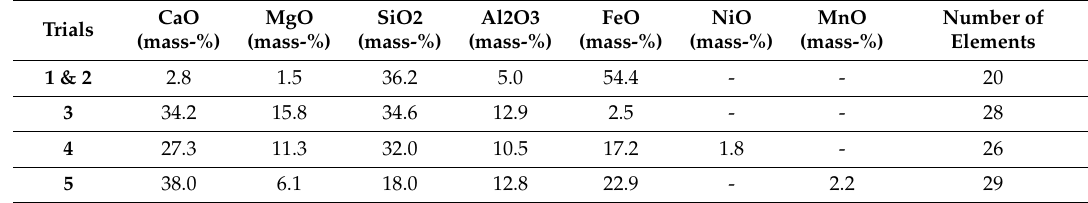
Table 8. Normalized slag composition for the different trials. The number of elements in the slag is also shown, these composition values were not included in the table due to the low amount per element.